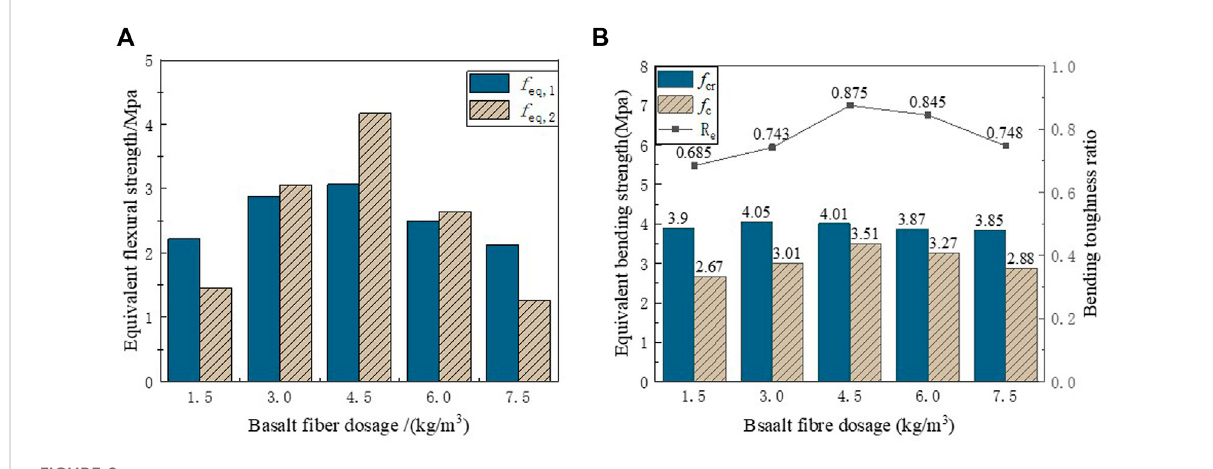
FIGURE 8 Equivalent bending strength measured by DBV-1998 and JSCE SF-4 (Jiao et al., 2019b) (A) The results measured by DBV-1998 (B) The results measured by JSCE SF-4.